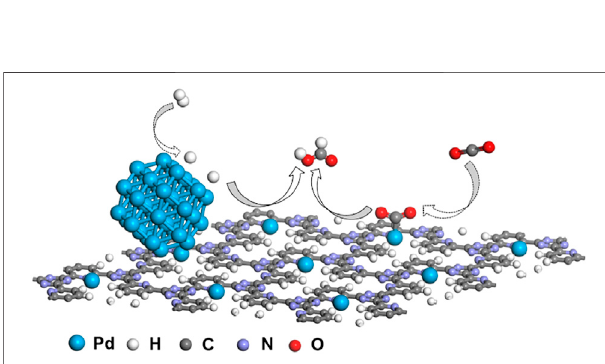
FIGURE 5 | Proposed synergistic effectmechanism of Pd/[ CTF-400 ] for the hydrogenation of carbon dioxide to formate.